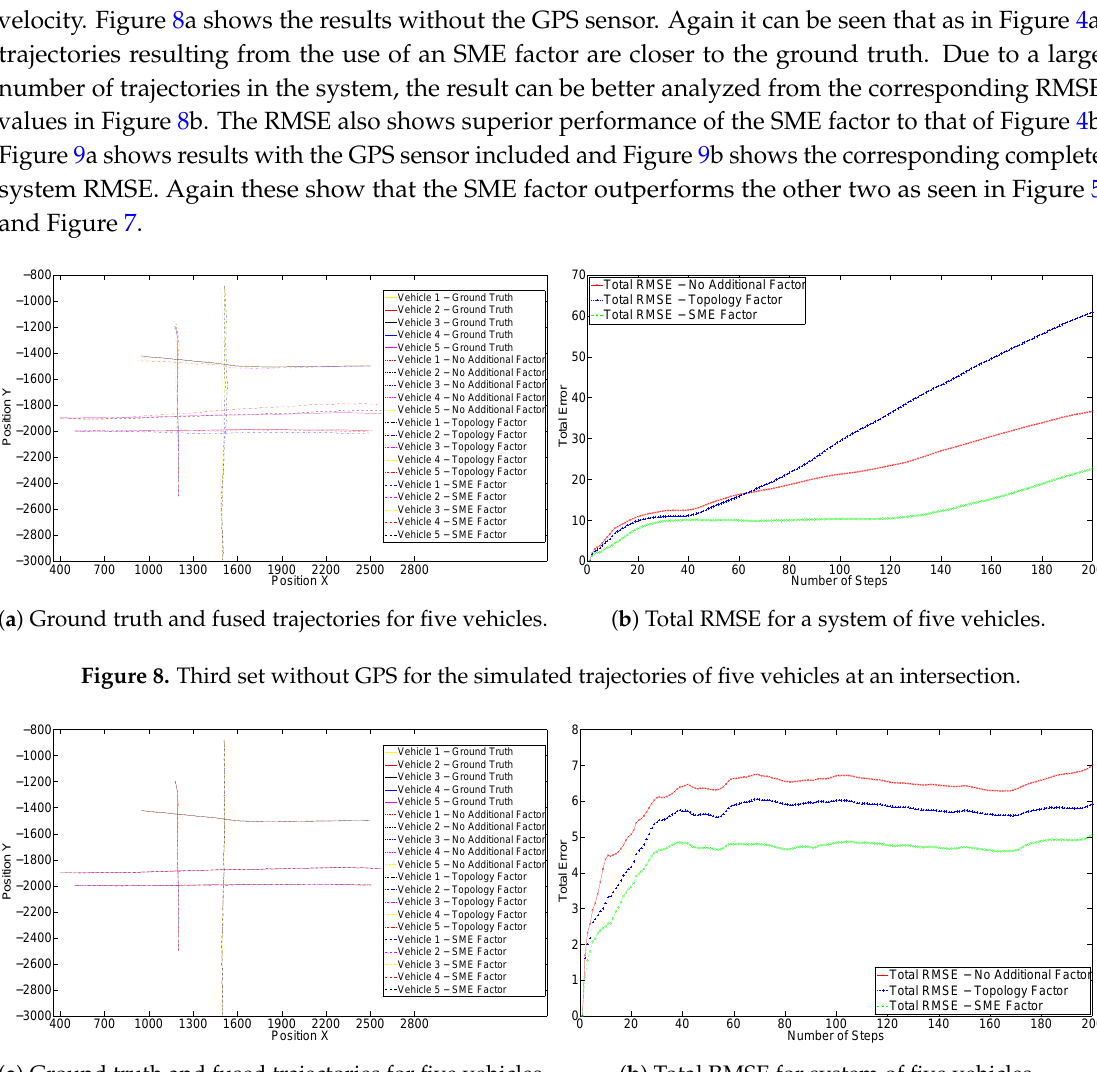
( b ) Total RMSE for system of five vehicles. Figure 9. Third set with GPS for the simulated trajectories of five vehicles at an intersection.